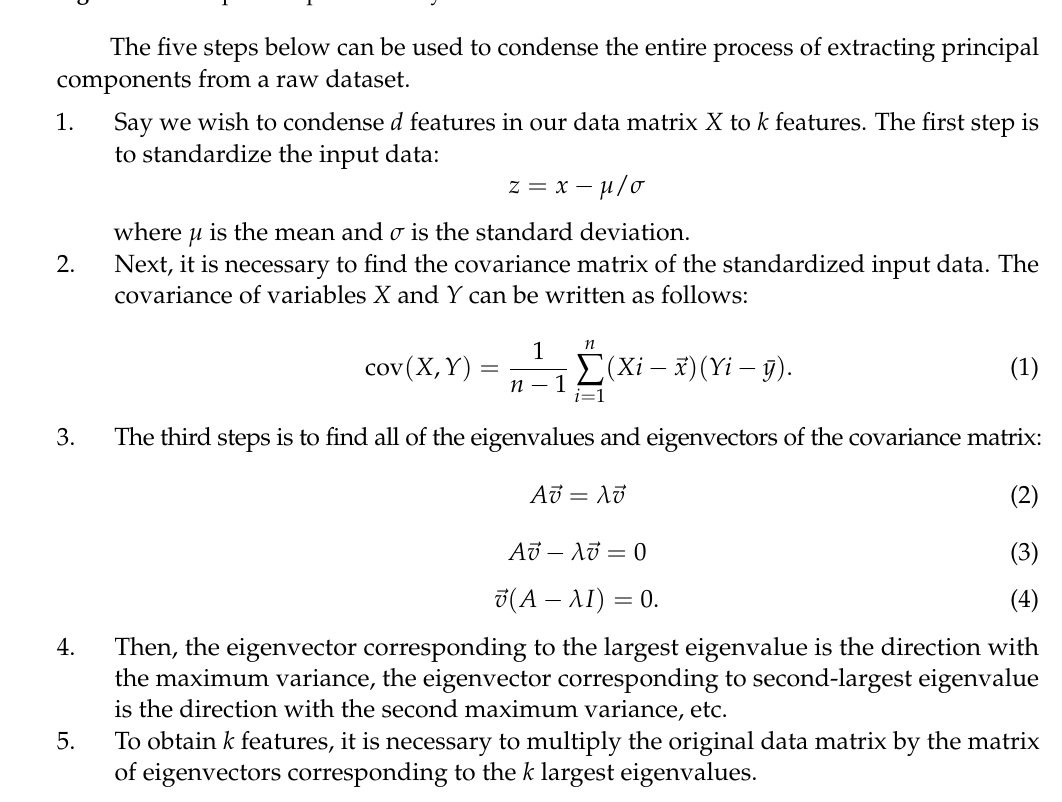
Figure 10. Principal Component